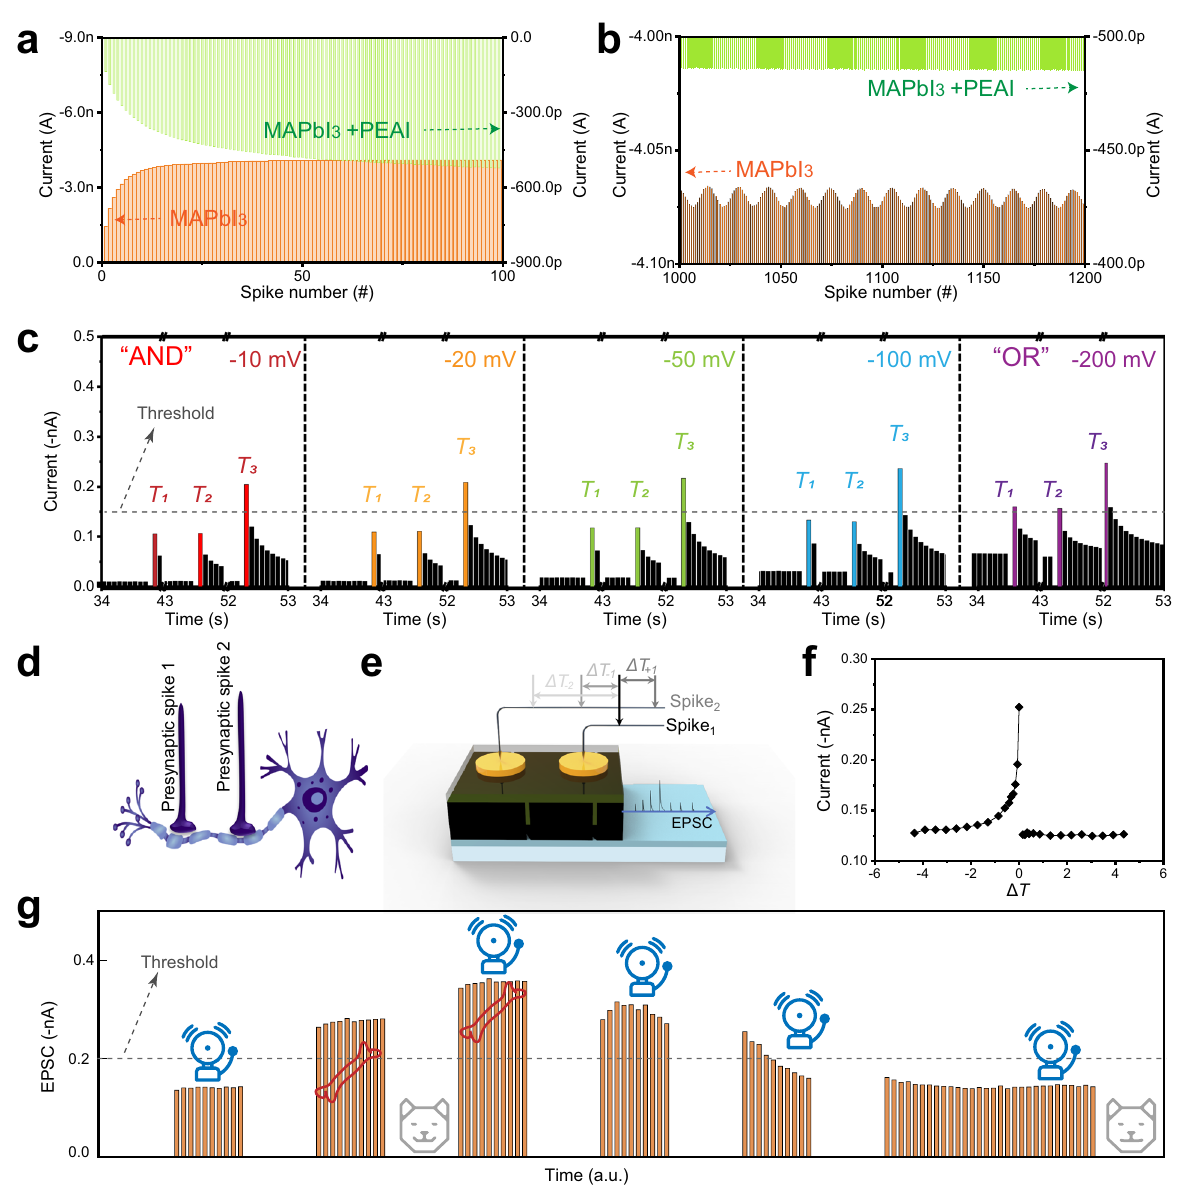
Fig. 4 | Logic, spatiotemporal correlation, and learning in RT-PVK arti fi cial synapses.a EPSCtriggeredby100consecutivespikes( − 0.5V,68ms)inperovskite arti fi cial synapse with/without PEAI passivation. b EPSC triggered by 2000 con- secutive spikes ( − 0.5V, 68ms) in perovskite arti fi cial synapse with/without PEAI passivation. c Logical operations in perovskite arti fi cial synapse with PEAI